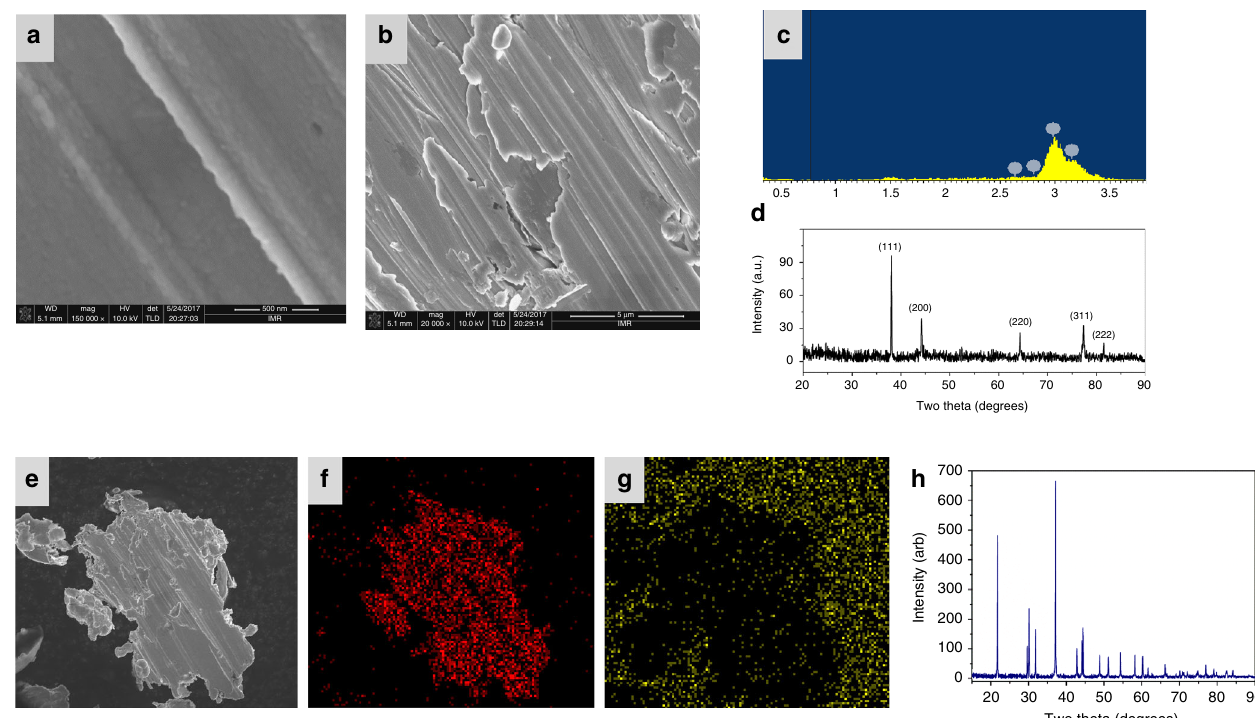
Fig. 6 Characterization of the thermal-decomposition residues of [Ag(NH 3 ) 2 ] + [Ag 3 (N 5 ) 4 ] ˉ . a SEM image at low magni fi cation. b SEM image at high magni fi cation. c EDS spectrum. d XRD pattern (JCPDS: 65-2871). e SEM image for mapping. f EDX mapping distribution of Ag. g EDX mapping distribution of N. h XRD analysis of the residue from the decomposition process of [Ag(NH 3 ) 2 ] + [Ag 3 (N 5 ) 4 ] ˉ in the fi rst weight loss